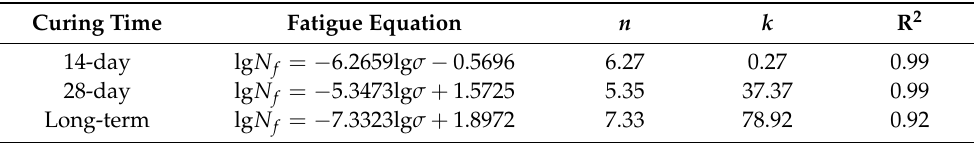
Table 6. Fatigue equation of CRME under different curing times. Curing